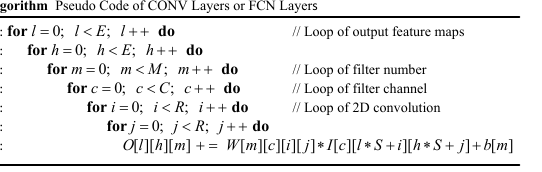
Algorithm Pseudo Code of CONV Layers or FCN Layer s